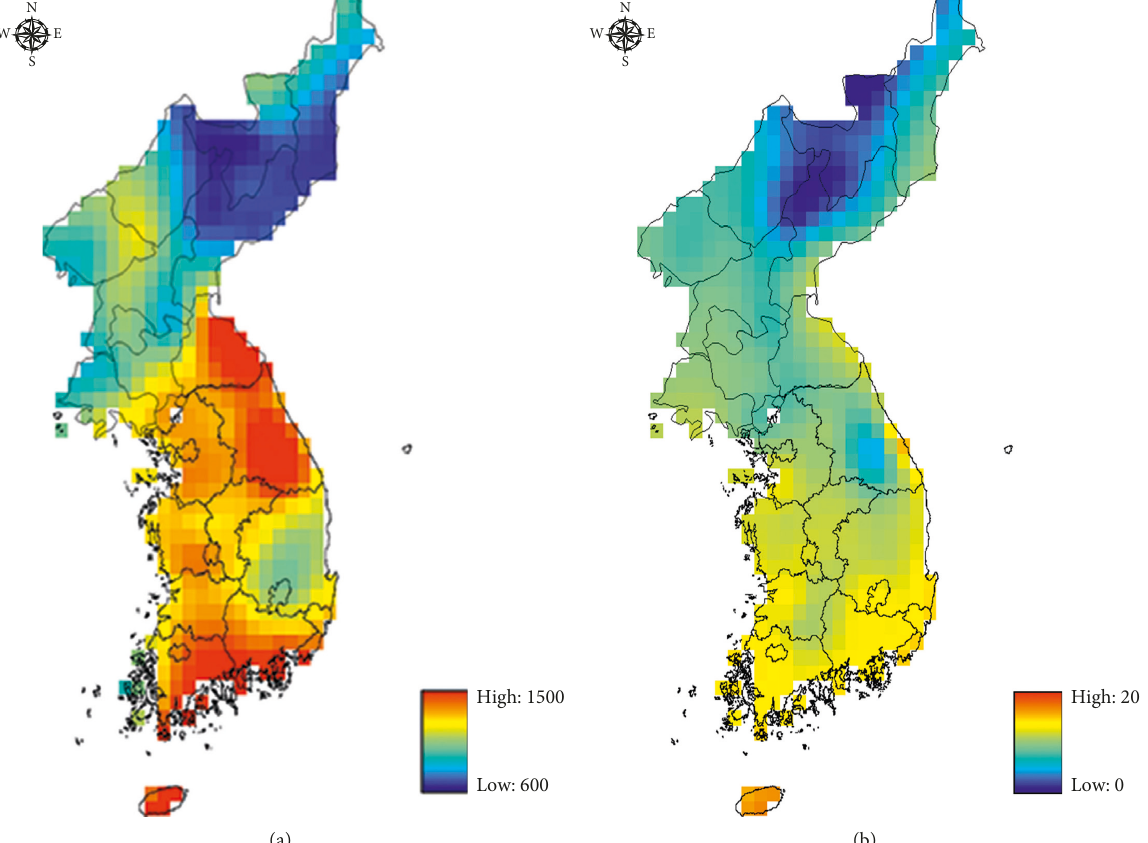
Figure 3: Annual precipitation and average temperatures over the Korean Peninsula. (a) Annual precipitation. (b) Annual average temperatures.